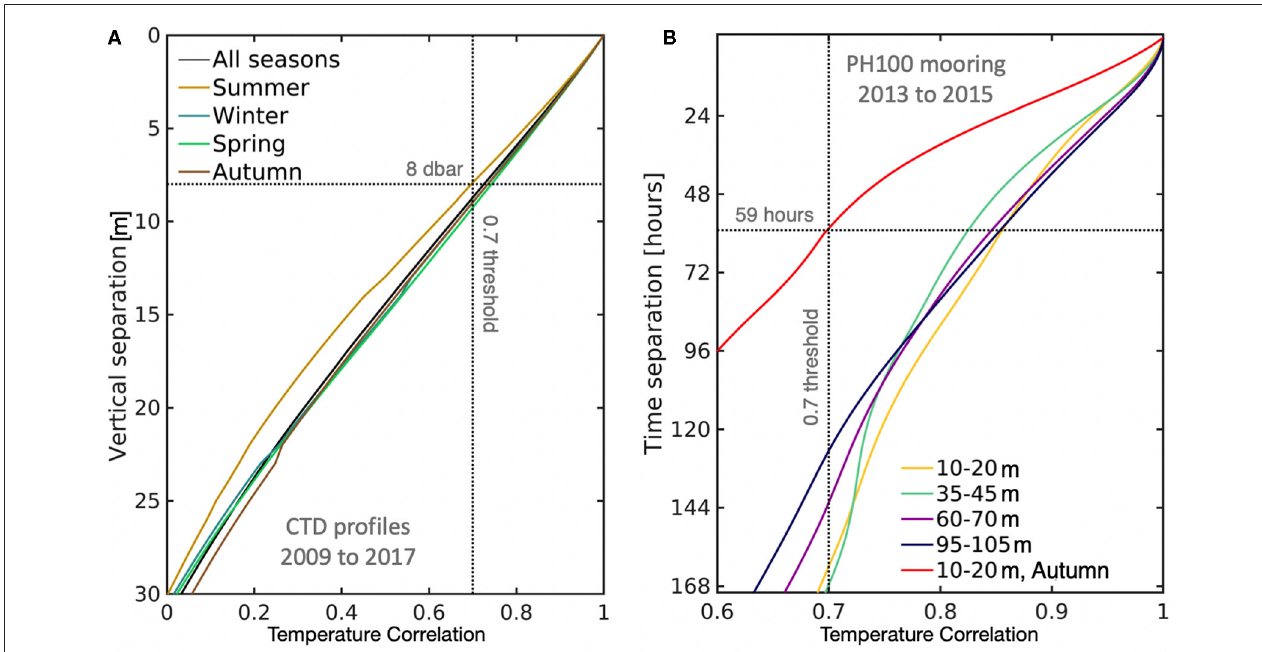
FIGURE 4 | The autocorrelation function of temperature observations in vertical space and time. (A) The temperature correlation coefficients determined using ship CTD profiles between 2009 and 2017 as a function of vertical separation [m] for all seasons, summer (DJF), winter (JJA), spring (SON), and autumn (MAM). (B) The temperature correlation coefficients determined using PH100 mooring temperatures between 2013 and 2015 as a function of time separation (hours) between 10 and 20m, 35 and 45m, 60 and 70m, and between 95 and 105m for all seasons. The lowest correlation temporal threshold is plotted using data in Autumn between 10 and 20m. Annotations are included in each sub panel describing the data that were used and the identified vertical and temporal correlation thresholds (labeled